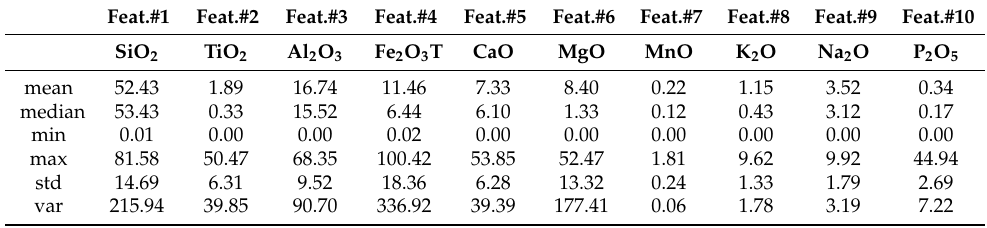
Table 5. Basic statistics of Dataset 3.